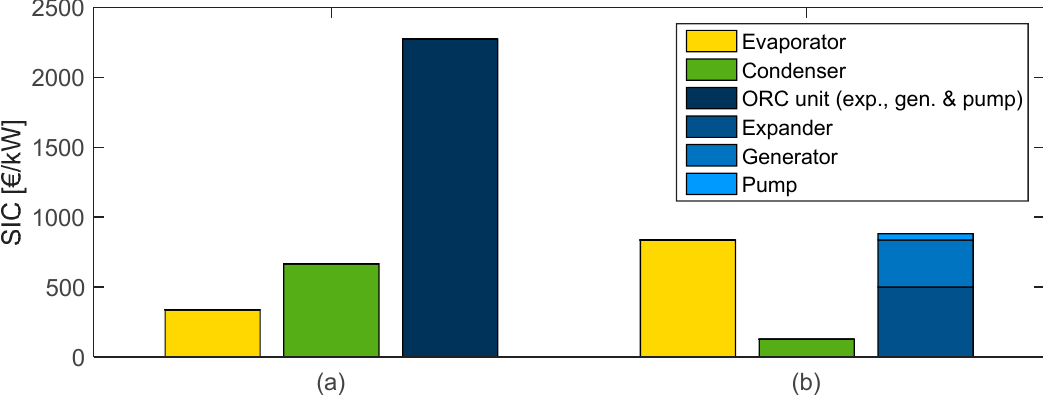
Figure 3. Real ( a ) and estimated ( b ) purchased equipment costs.